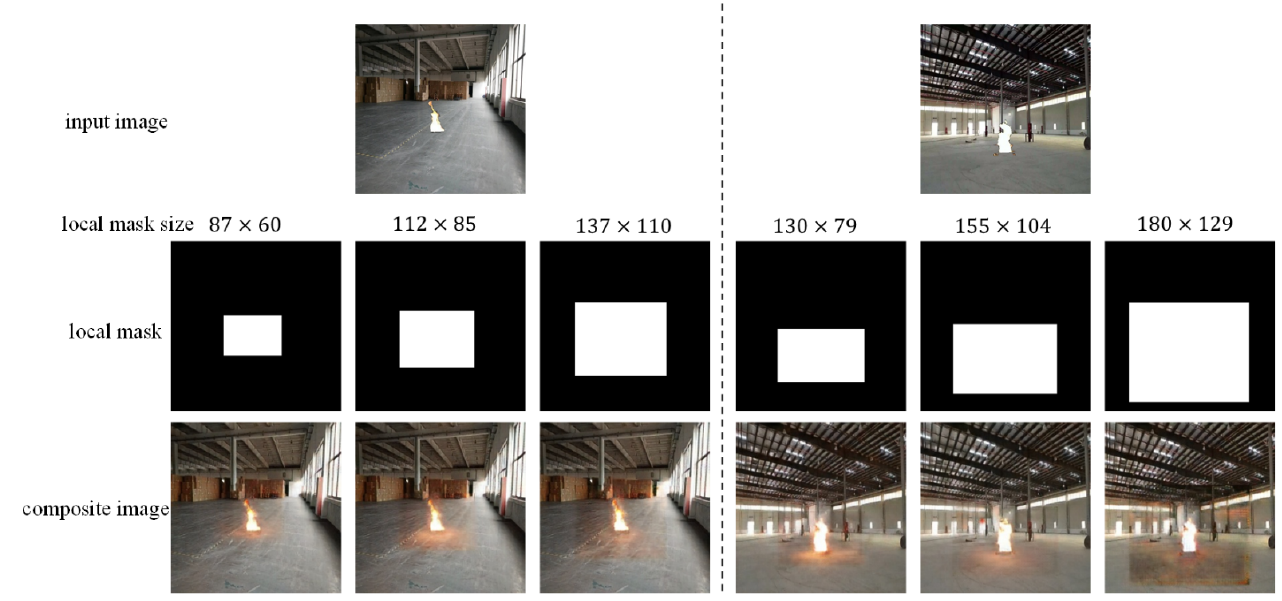
Figure A3. The effect of the size of the local mask on the area of flame reflection.